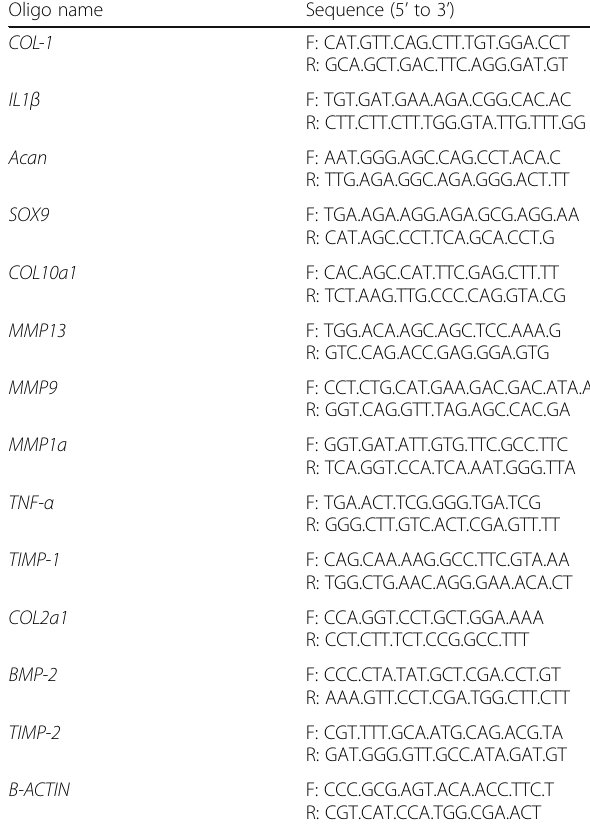
Table 1 Primer sequences of various rat genes used for qPCR Oligo